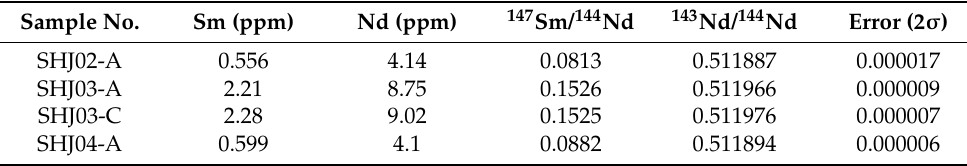
Table 2. Fluorite Sm and Nd isotopic compositions of the Shuanghuajiang fluorite deposit. Sample